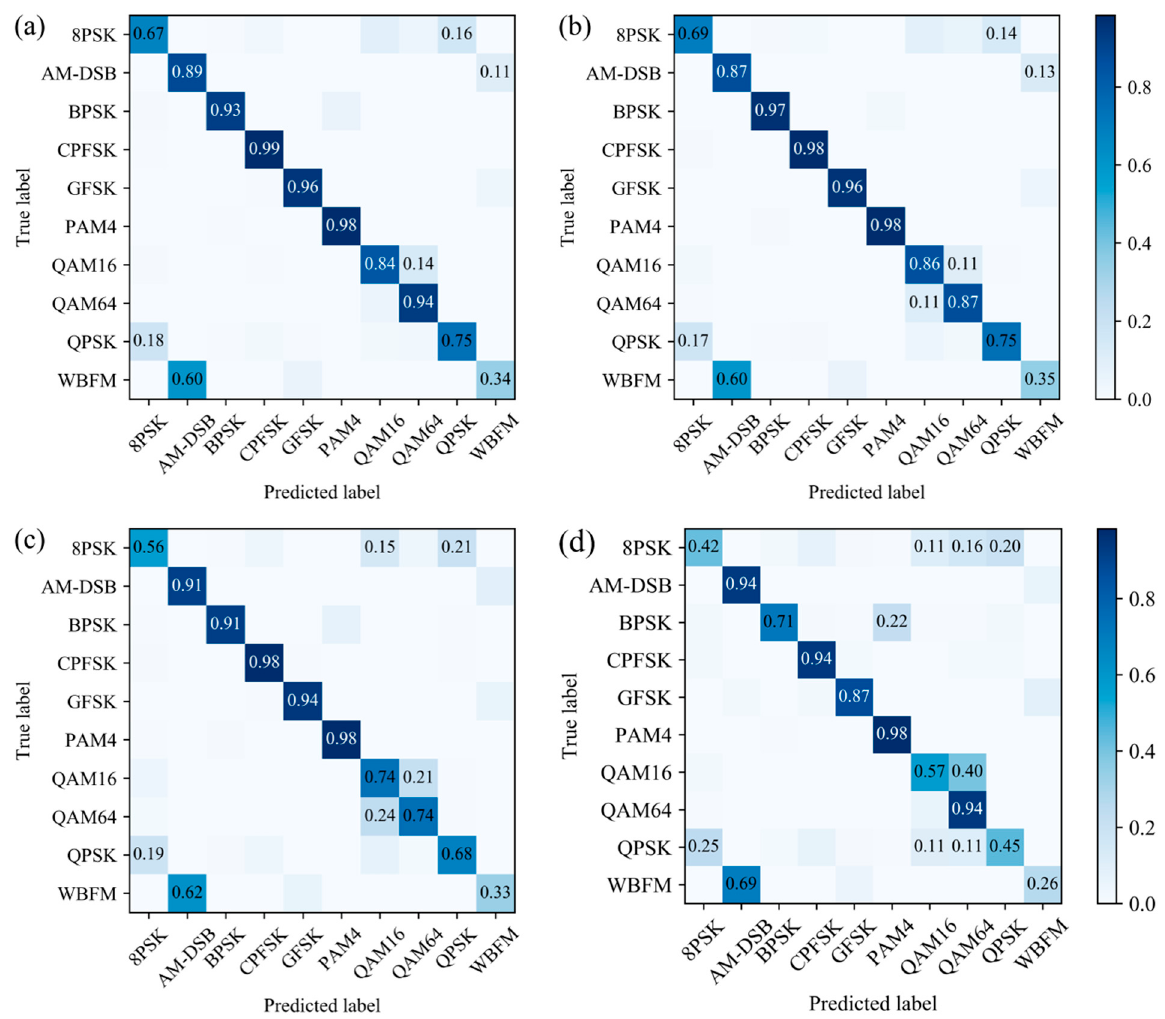
Figure 11. Confusion matrix of network structures under different data augmentation methods with SNRs of − 2 dB: ( a ) scaling; ( b ) magnitude warping; ( c ) time warping; ( d ) original training set.